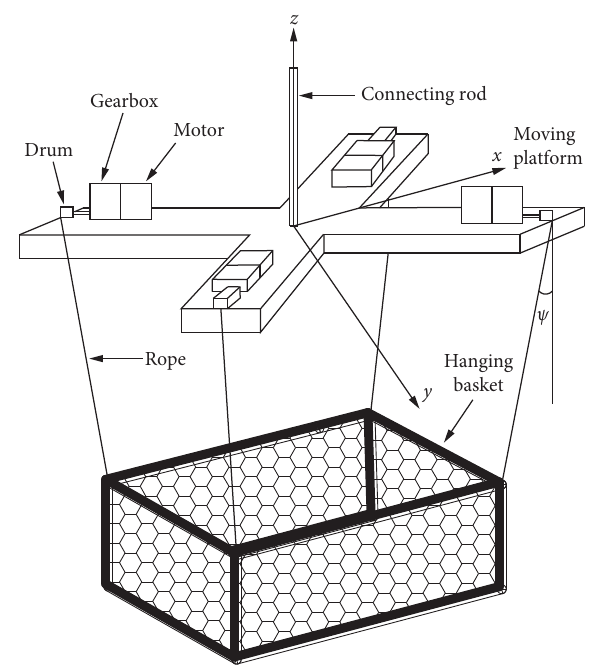
F IGURE 3: Structure of batch transfer hanging basket